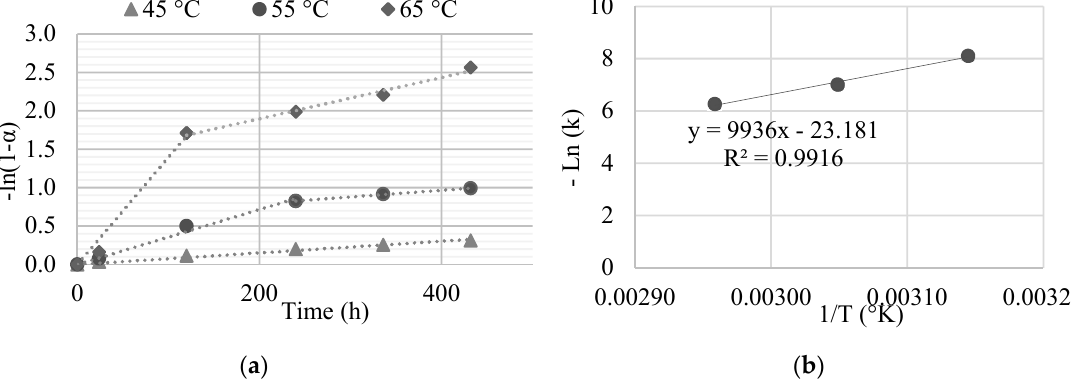
Figure 12. ( a ) Kinetic model versus time (h) at different temperatures. ( b ) Arrhenius plot.